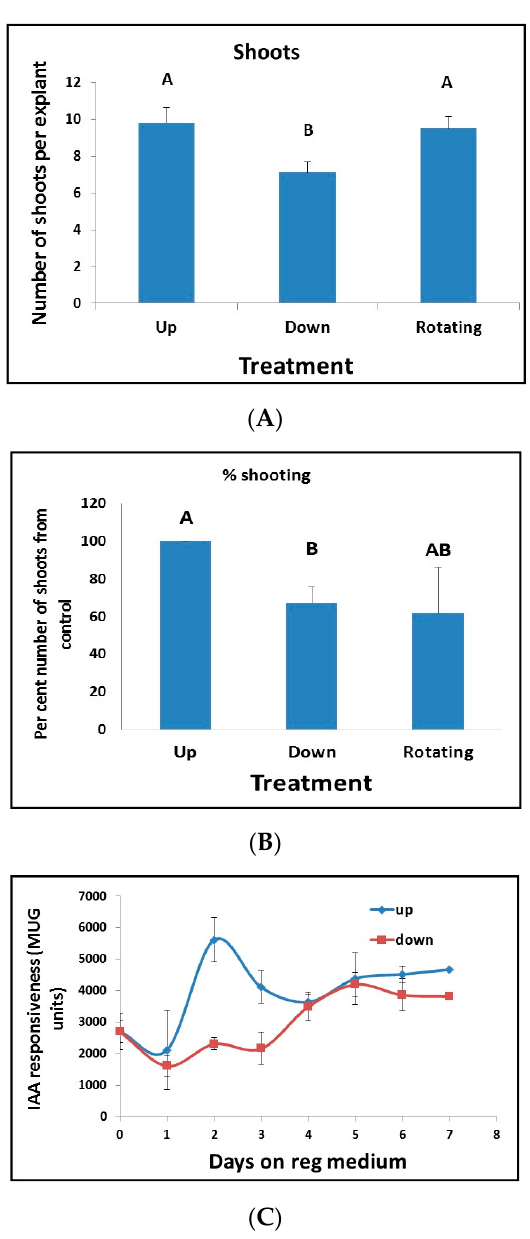
Figure 10. The orientation of leaf segment affects shoot regeneration and percent regeneration. ( A ) Number of shoots regenerated from leaf segments placed with the segment above the agar Reg medium ( Up ); leaf segments placed with the segment on the agar and the plates turned upside down, thus, the segment are beneath the agar Reg medium ( Down ) but still exposed to the air on one side or leaf segments placed with the segment above the agar Reg medium, and the plate was rotated at 30 rotations per min ( Rotating ). Results are the mean ± se of five repetitions representing 802 leaf segments. Different letters (A, B) define statistically different results ( B ) Percent regeneration from leaf segments placed as in ( A ), percent shooting was calculated as the number of segments that produced at least one shoot out of a total number of the segment in a plate. Results are the mean ± se of five repetitions for each treatment. Different letters (A, B) define statistically different results ( C ) Effect of positioning leaf segments containing the auxin reporter transgene IAA/AUX3::GUS above or beneath the agar medium on IAA responsiveness; up and down as in A. Each point is the mean ± se of five measurements of GUS activity done on ten individual leaf